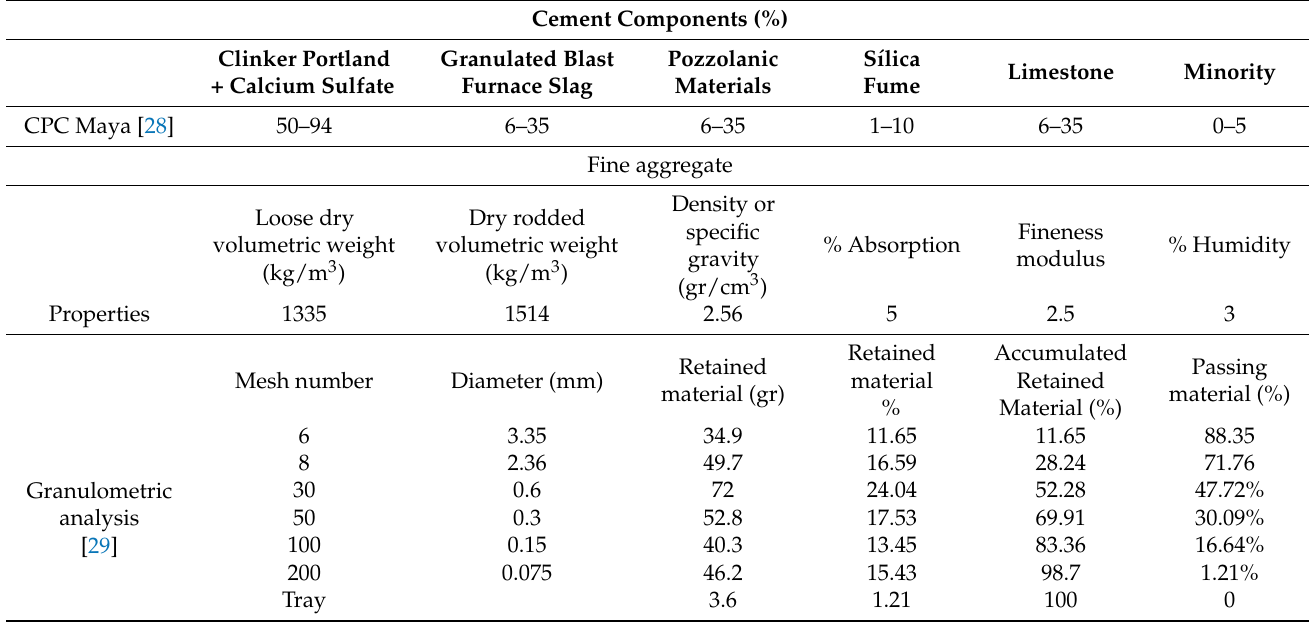
Table 1. Components of the mortar samples.